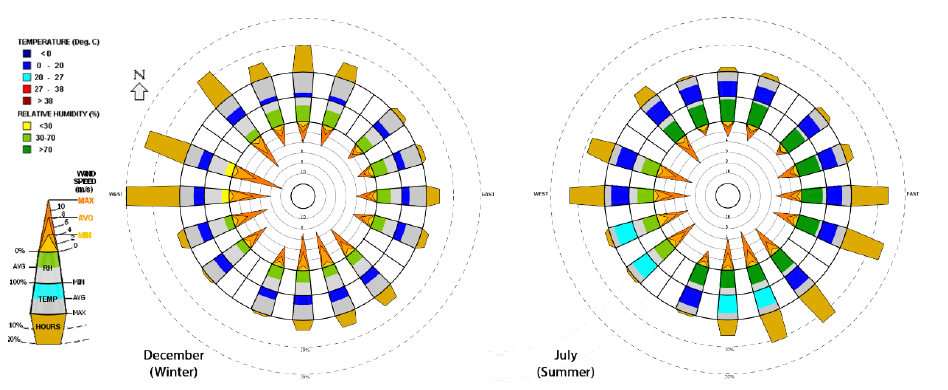
Figure 4. Wind wheels of Lijiang winter (left) and summer (right) (diagrams generated with Climate